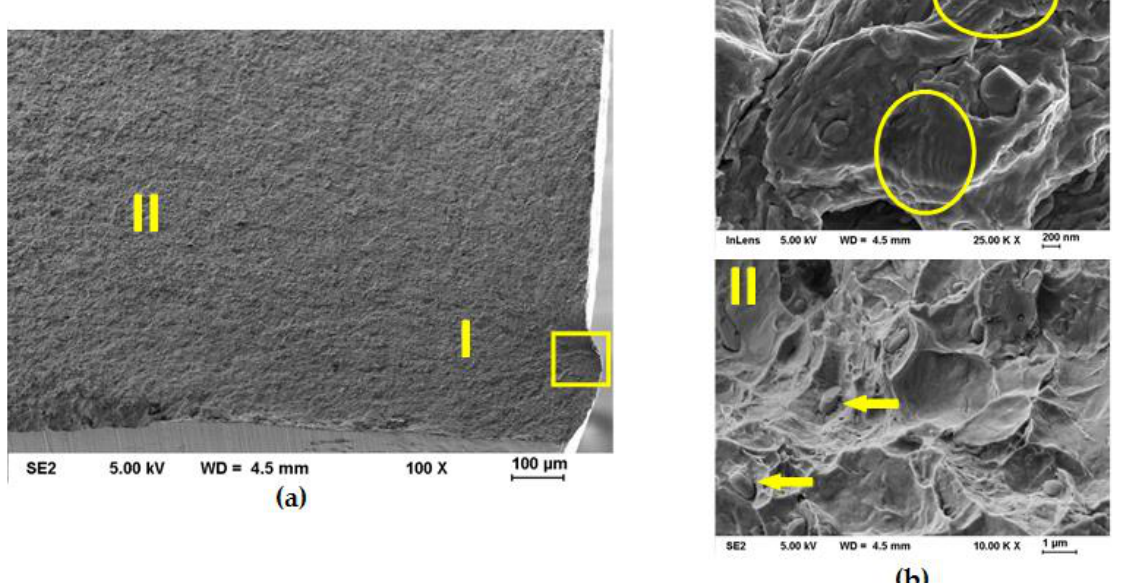
Figure 12. ( a ) Fatigue fracture surface of a QP2 specimen with ( b ) different fracture areas.